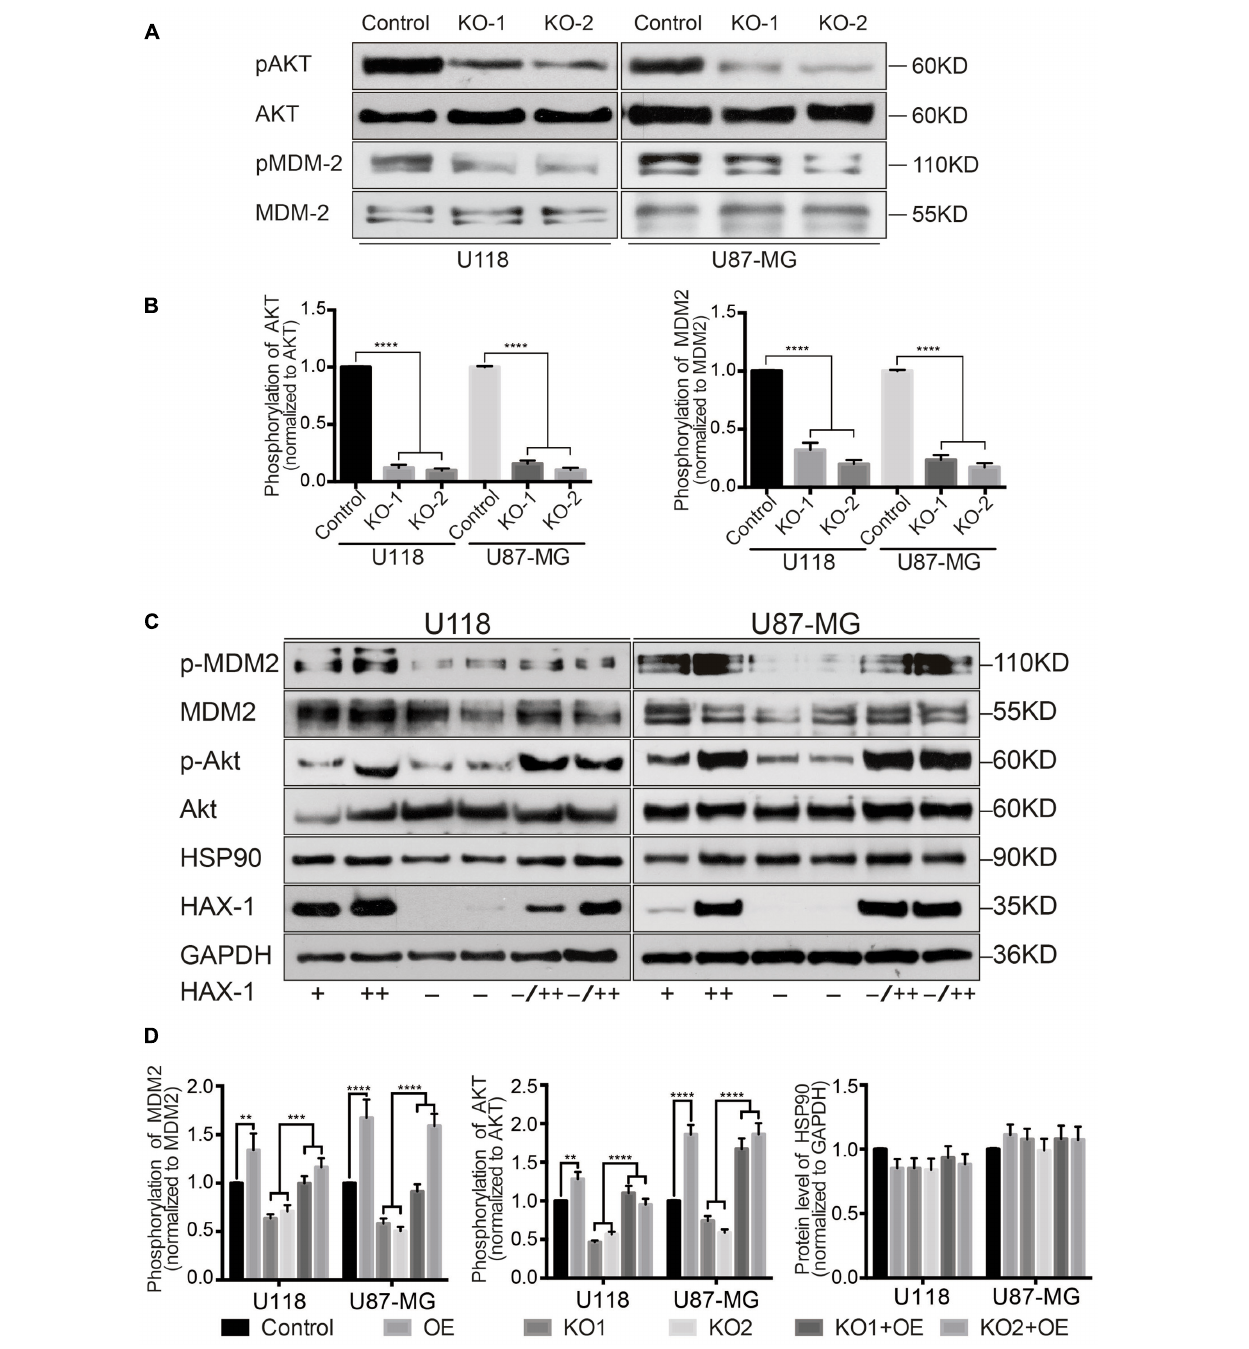
FIGURE 6 | HAX-1 is involved in the phosphorylation of Akt1 and MDM2. (A,B) The phosphorylation of MDM2 and Akt1 was investigated, and HAX-1 knock-out reduces the level of phosphorylation. Akt1 and MDM-2 were used as loading controls. (C,D) Western blot showed the phosphorylation level of Akt1 and MDM-2 and the expression of Hsp90 with different HAX-1 levels. Akt1, MDM-2 and GAPDH were used as loading controls. Three individual experiments were performed for each group. ∗∗ P < 0.01, ∗∗∗ P < 0.001, ∗∗∗∗ P < 0.0001.